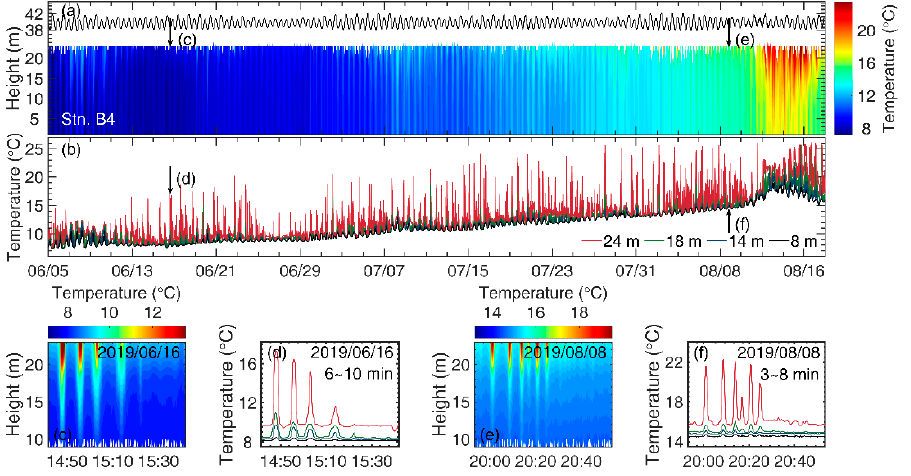
Figure 3. The same as in Figure 2 but for Stn. B4.